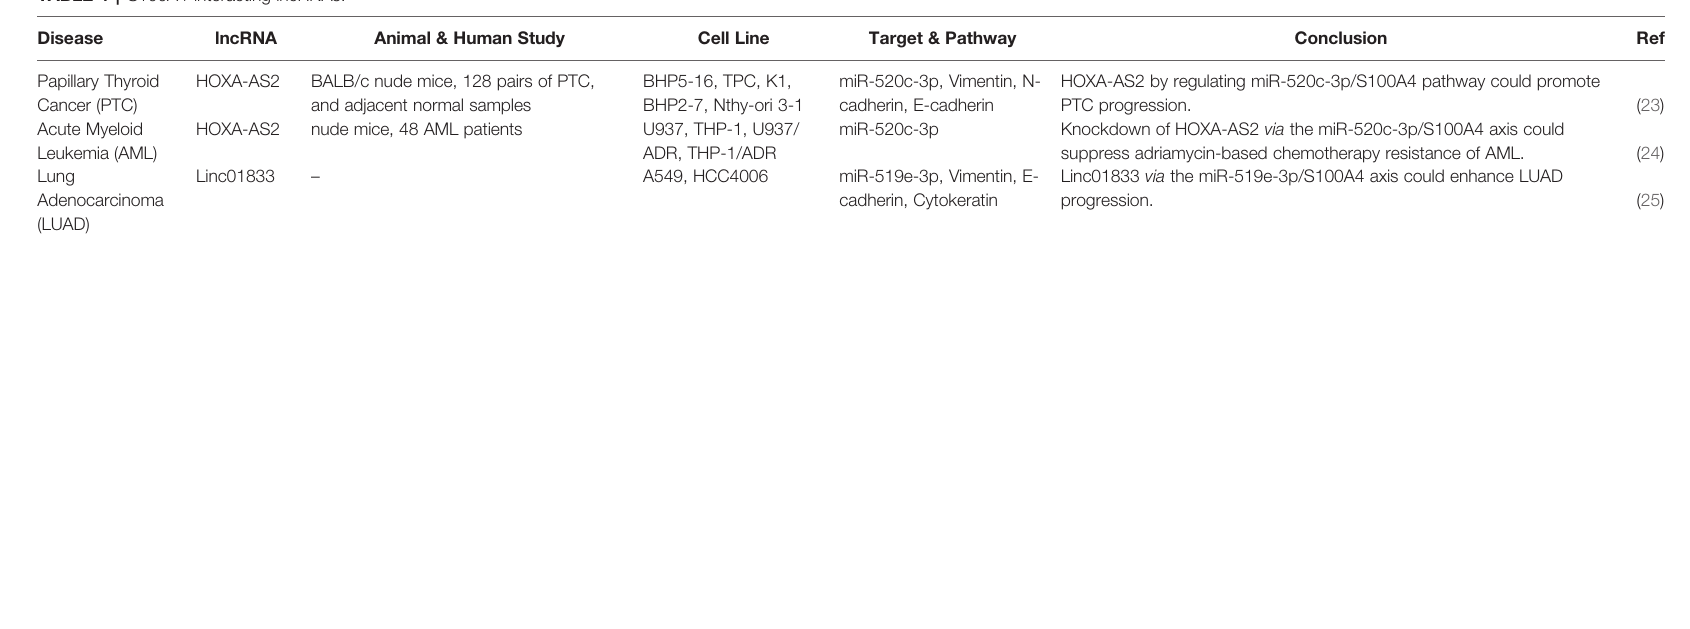
TABLE 4 | S100A4-interacting